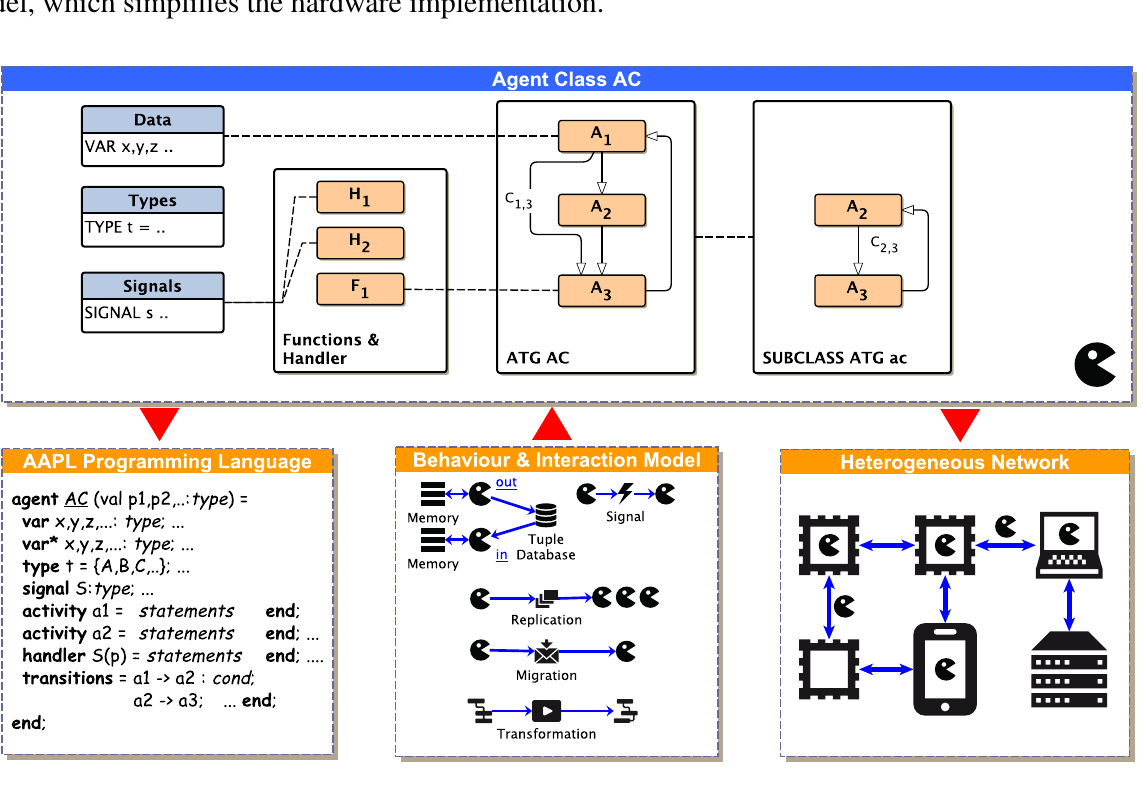
Figure 2. Agent behavior programming level with activities and transitions (Activity-Based and Agent-orientated Programming Language (AAPL) ( left )); agent class model and activity-transition graphs ( top ); agent instantiation, processing and agent interaction on the network node level ( right )